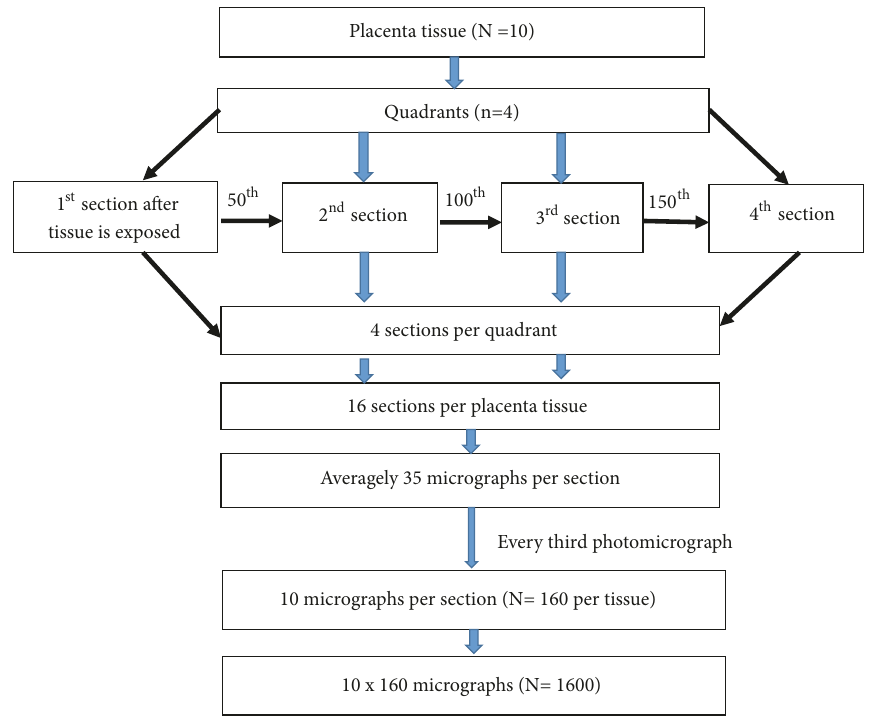
Figure 1: Summary of stereological systematic random